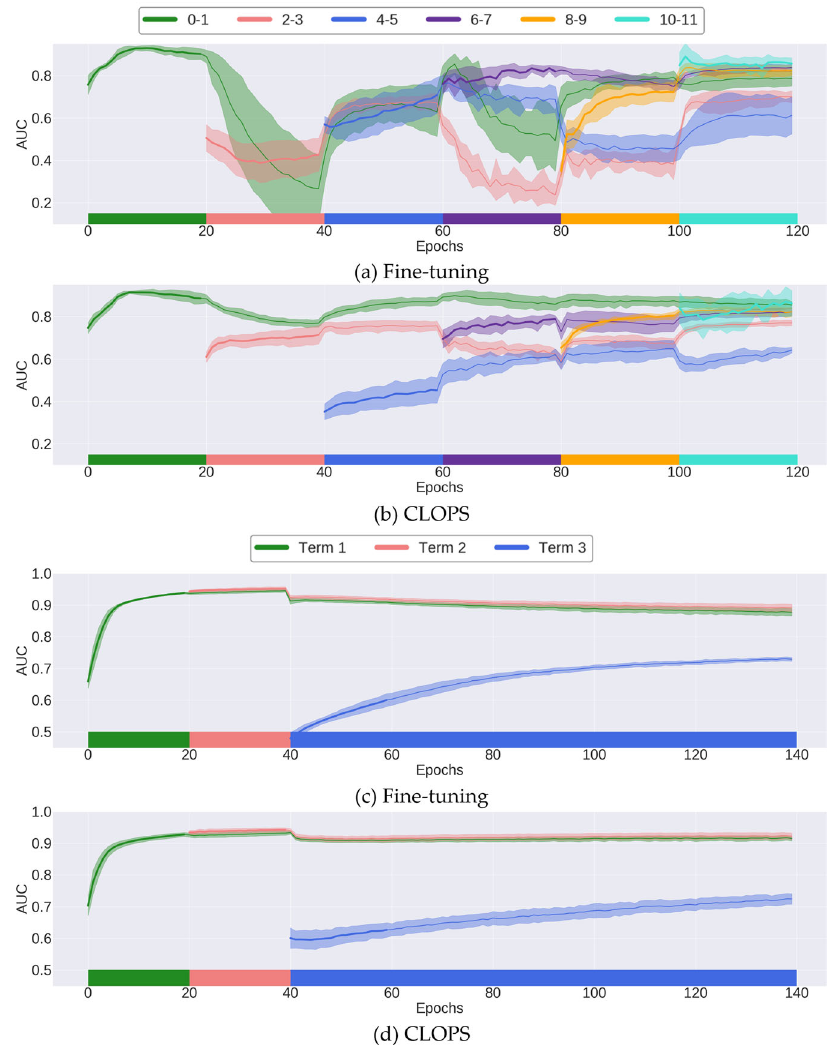
Fig. 2 Performance of fi ne-tuning and continual deep-learning system in various continual learning scenarios. We present the performance of the ( a ) Fine-tuning strategy and ( b ) CLOPS in the Class-IL scenario which is characterized by six sequential tasks. We also present the performance of the ( c ) Fine-tuning strategy and ( d ) CLOPS in the Time-IL scenario which is characterized by three sequential tasks. The x -axis denotes the number of training epochs, the colored blocks re fl ect the task currently being trained on by the deep-learning system, and the y -axis denotes the average AUC. The performance of the fi ne-tuning system on tasks not currently being trained on degrades signi fi cantly, demonstrating catastrophic forgetting. CLOPS dramatically mitigates this catastrophic forgetting. The results are an average across fi ve seeds and the shaded area represents one standard deviation from the